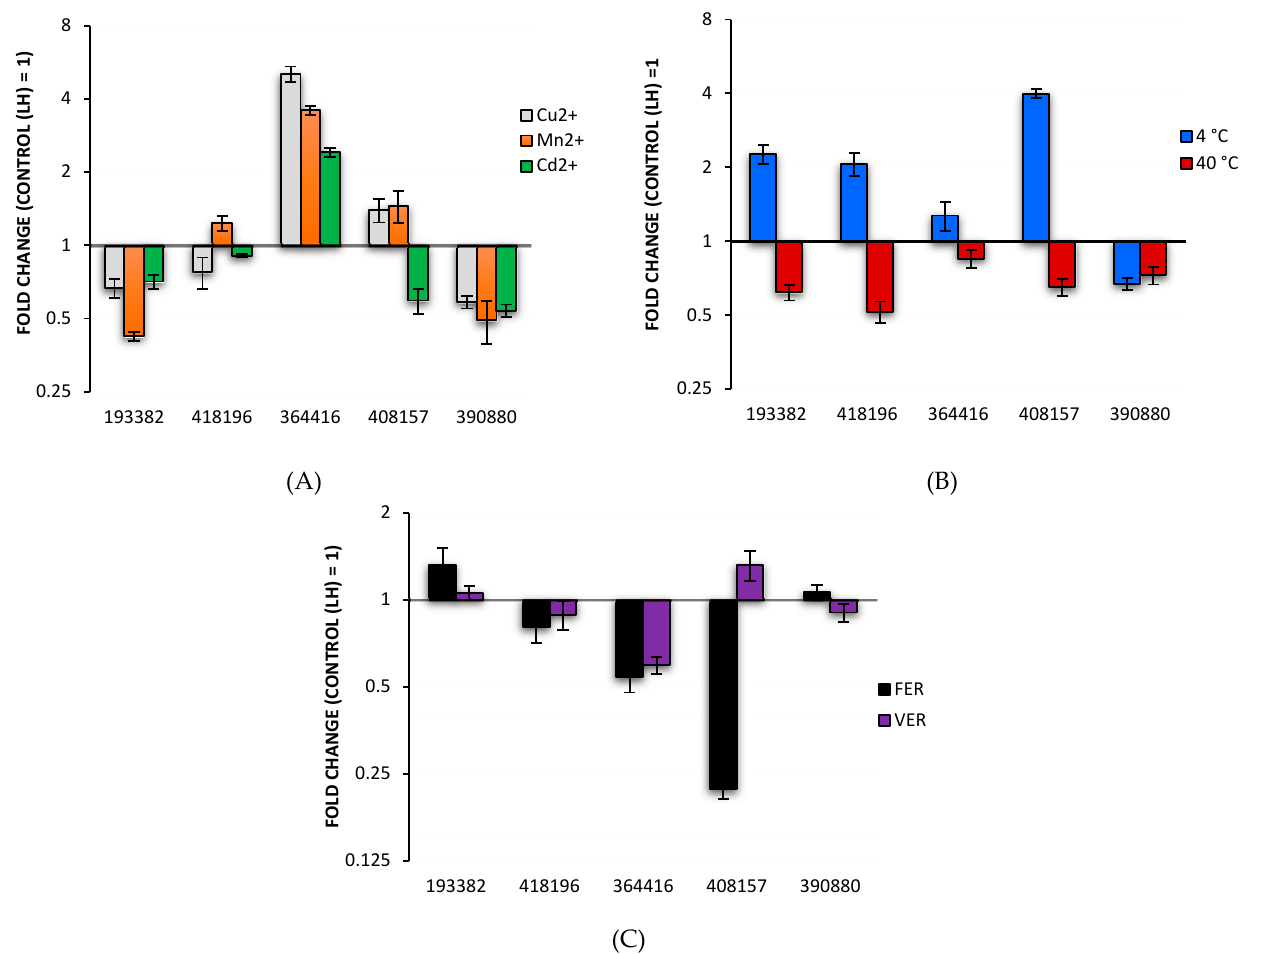
Figure 1. Effect of ( A ) Cu, Mn, and Cd ions, ( B ) temperature of 4 and 40°C, and ( C ) ferulic (FER) and veratric (VER) acids on the expression of seven C. unicolor laccase genes. Error bars represent the standard deviations of the mean ± SD for three independent measurements ( n = 3). LH – Lindeberg and Holm medium.